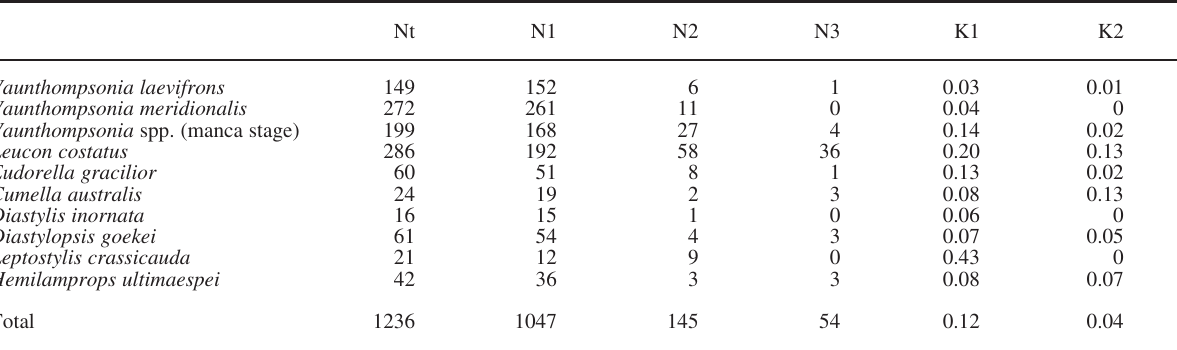
) and 100-140 cm (N ) near-bottom 2 3 = N /N and K = N /N 1 2 t 2 3 t